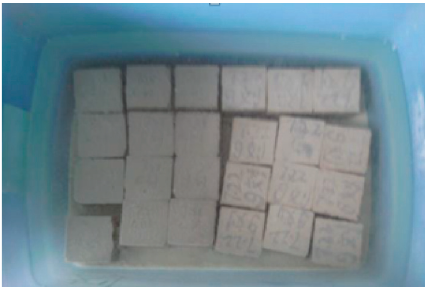
Figure 2: Solidified soil